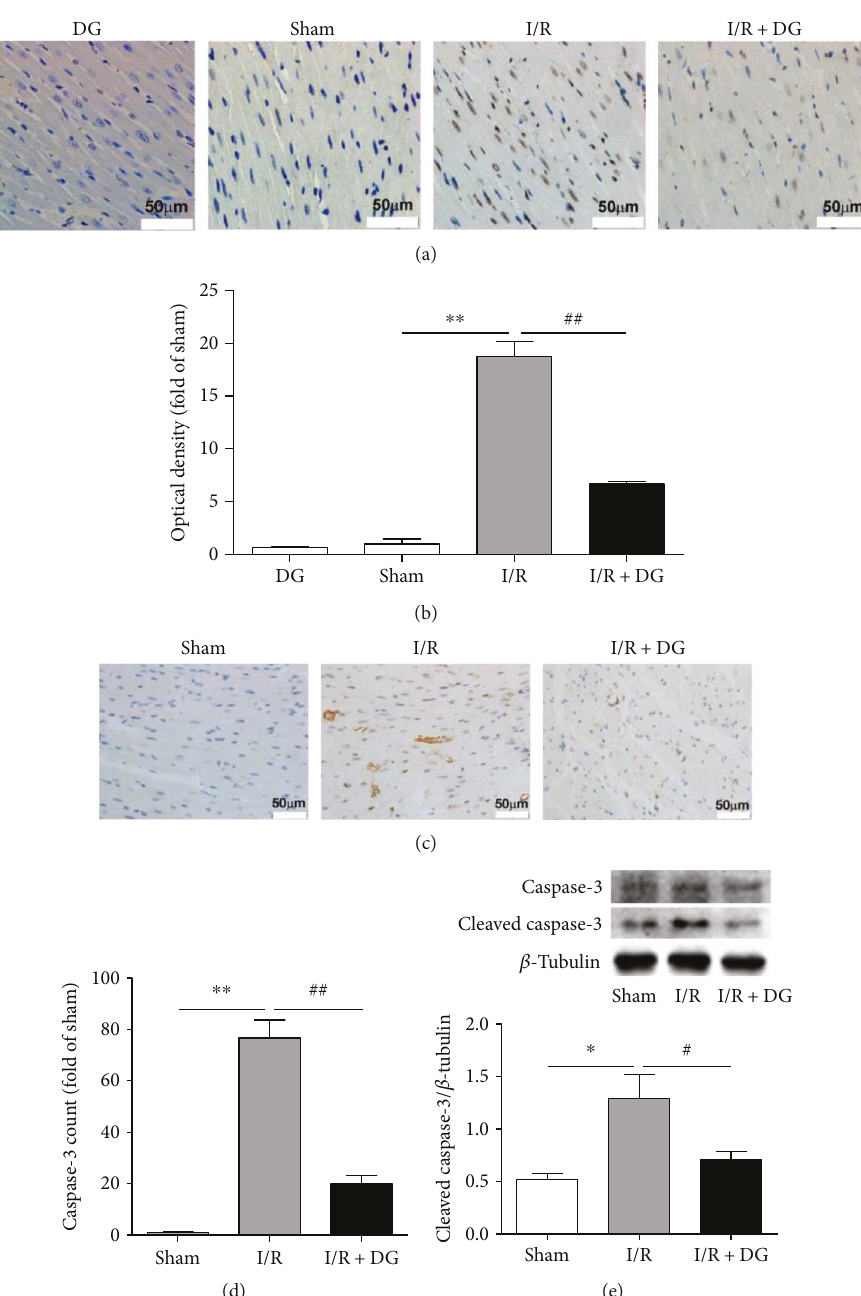
Figure 2: Dunye Guanxinning inhibited myocardial apoptosis. (a) Immunochemical TUNEL staining; (b) multiples of optical density of TUNEL staining from Figure 2(d) ( n = 3 ); (c) immunochemical staining of anti-caspase-3 (cleaved) antibody; (d) multiples of cleaved caspase-3 staining positive cells from Figure 2(a) (each n = 3 ); (e) caspase-3 immunoblot of left ventricular tissue (each n = 4 ). Data are expressed as mean ± SD. ∗ P < 0 05 or ∗∗ P < 0 01 versus sham operation group; # P < 0 05 or ## P < 0 01 versus ischemia-reperfusion